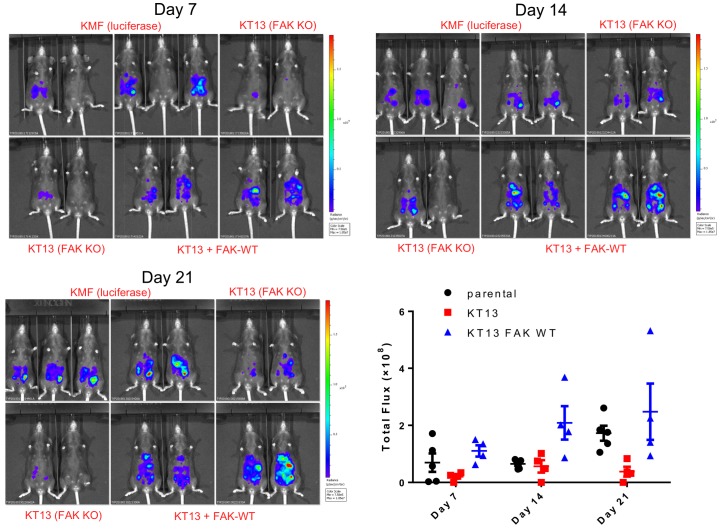
Comparison of KMF, KT13 FAK KO, and FAK KO re-expressing GFP-FAK-WT orthotopic growth in C57Bl/6 mice.Representative IVIS imaging of C57Bl/6 mice with dTomato+ and luciferase-expressing KMF or KT13 KO cells at experimental Days 7, 14 and 21. Flow cytometry analyses of peritoneal wash collected dTomato+ cells at Day 28 of mice bearing KMF (black), KT13 FAK KO (red), and KT13 FAK KO re-expressing FAK WT (blue) cells. Values are means expressed as percent of total cells in peritoneal wash.